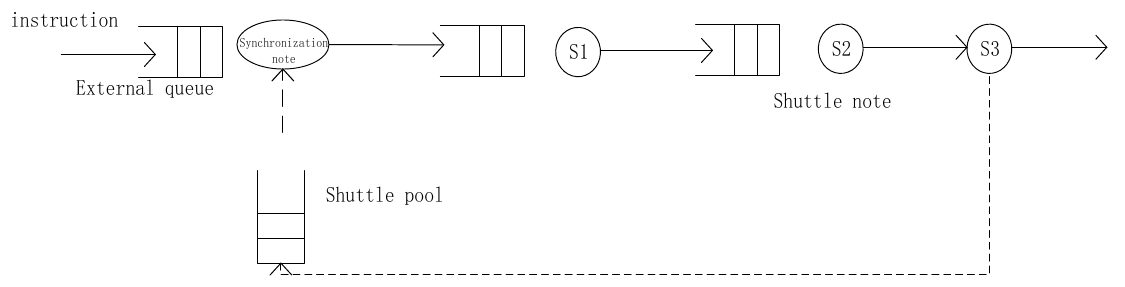
Figure 6. Semi-open-loop queuing network using the serial strategy.